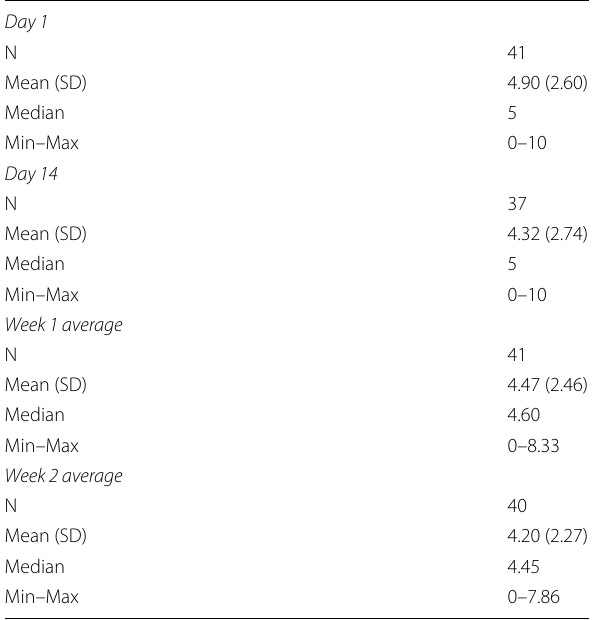
Table 2 2‑Week diary study average Urgency NRS scores